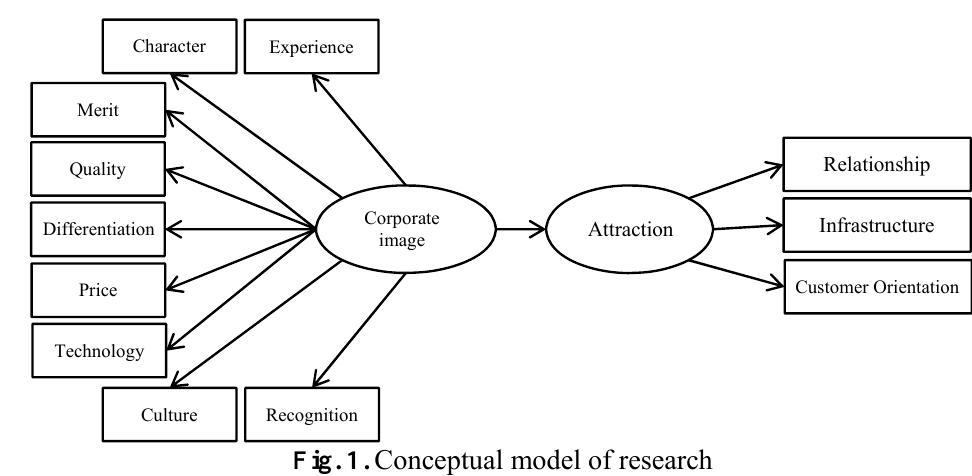
Fig. 1. Conceptual model of